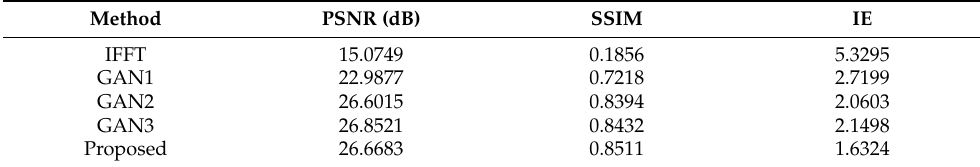
Table 4. Numerical performance evaluation for simulated aircraft at SNR = − 4 dB.